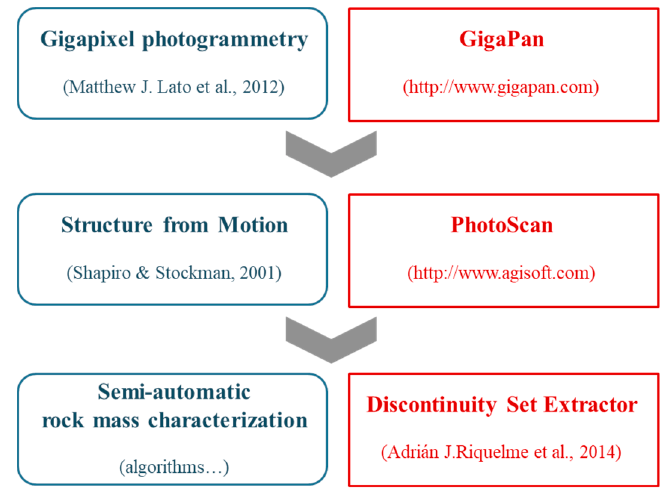
Figure 2. Block diagram showing techniques and steps used for rock mass characterization.